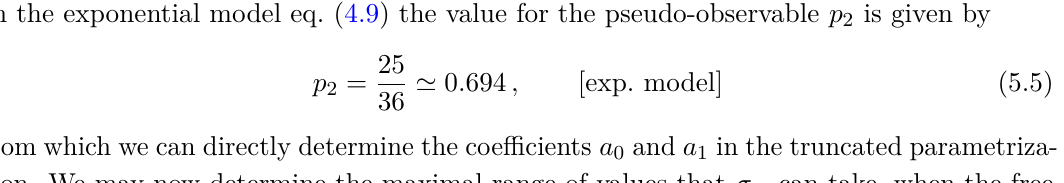
. We show the model B and the total variation of the parametrized B and a small a into 0 /λ B 2